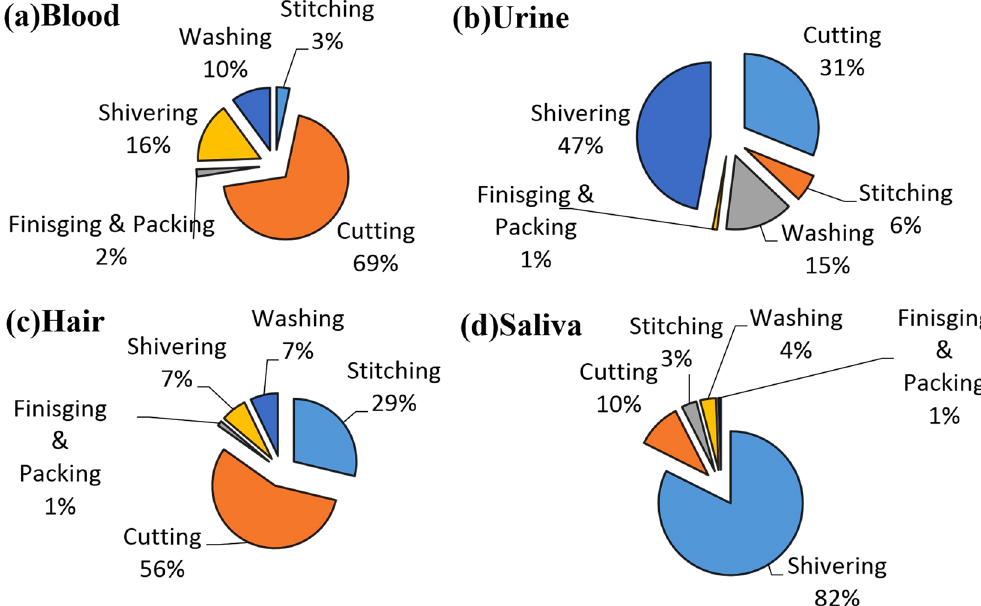
Figure 3. PCA-MLR based percentage contributing sources for the contamination of heavy metals in different biological matrices of occupationally exposed workers in the leather industries of Sialkot, Pakistan.